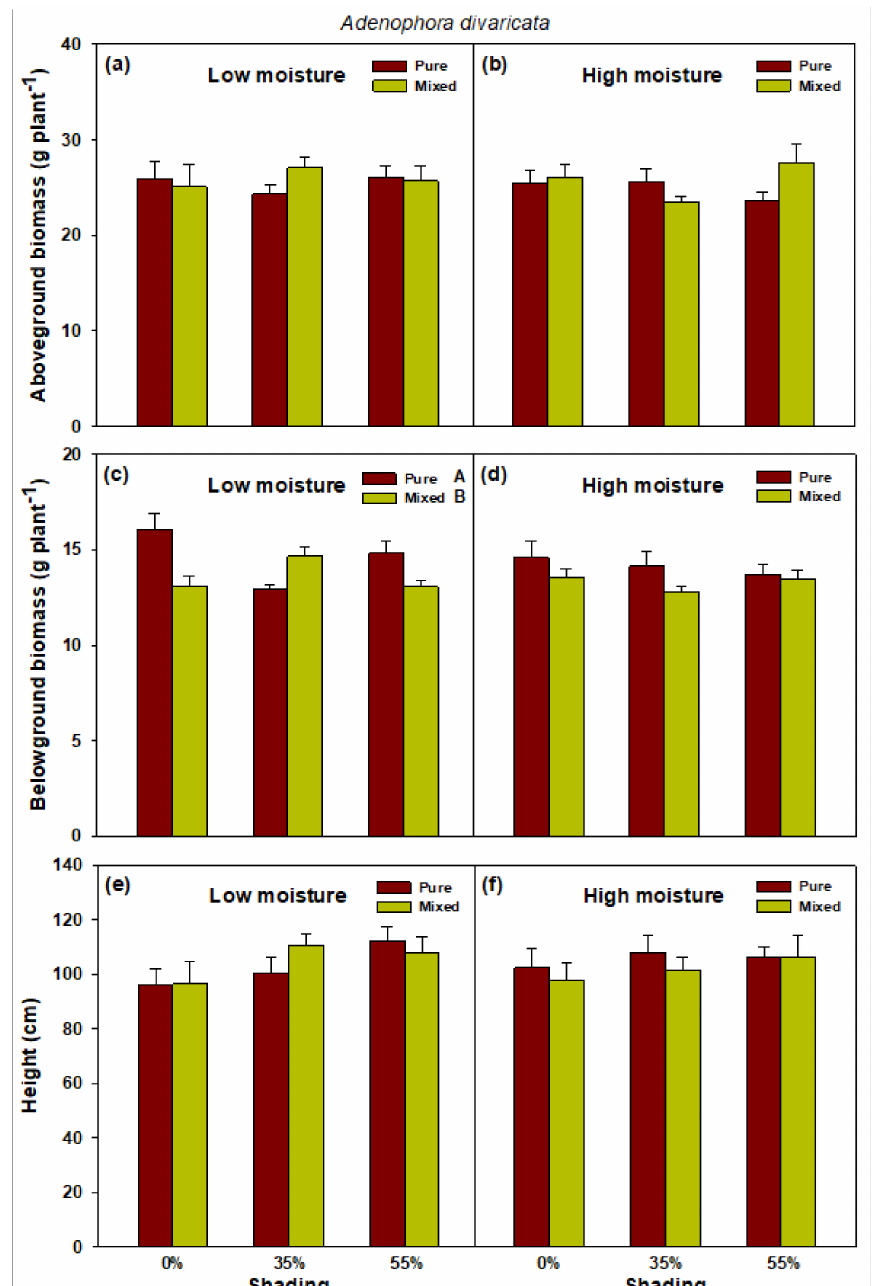
Figure 5. Aboveground biomass ( a , b ), belowground biomass ( c , d ), and height ( e , f ) of pure Adenophora divaricata and mixed Heracleum moellendorffii + Adenophora divaricata in different light and soil moisture conditions. Different lowercase and uppercase letters indicate statistical significance across shade treatments and between planting methods, respectively. Vertical bars show standard errors ( n =